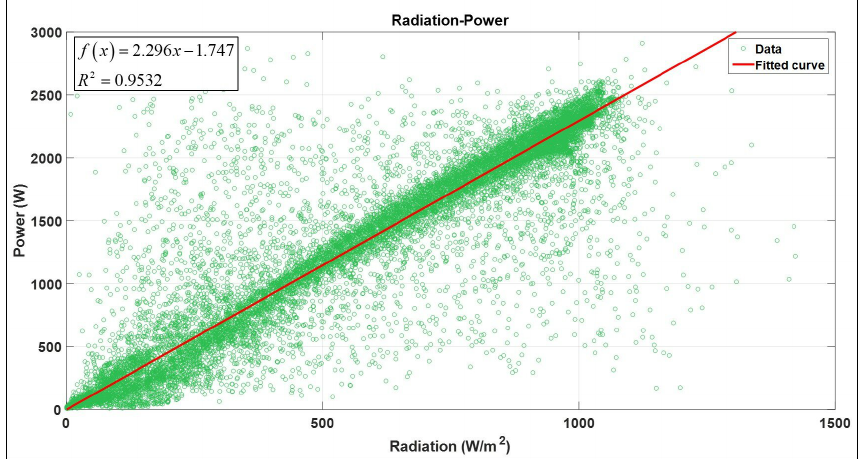
Figure 4. The Power vs. Solar radiation of HS.